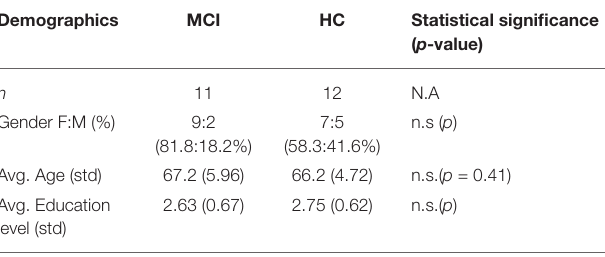
TABLE 2 | Demographics of participants (MCI, Mild Cognitive Impairment; HC, Healthy Controls) including number of participants, gender (F, female; M, male), age and education level (2: secondary education, 3: higher education, 4: